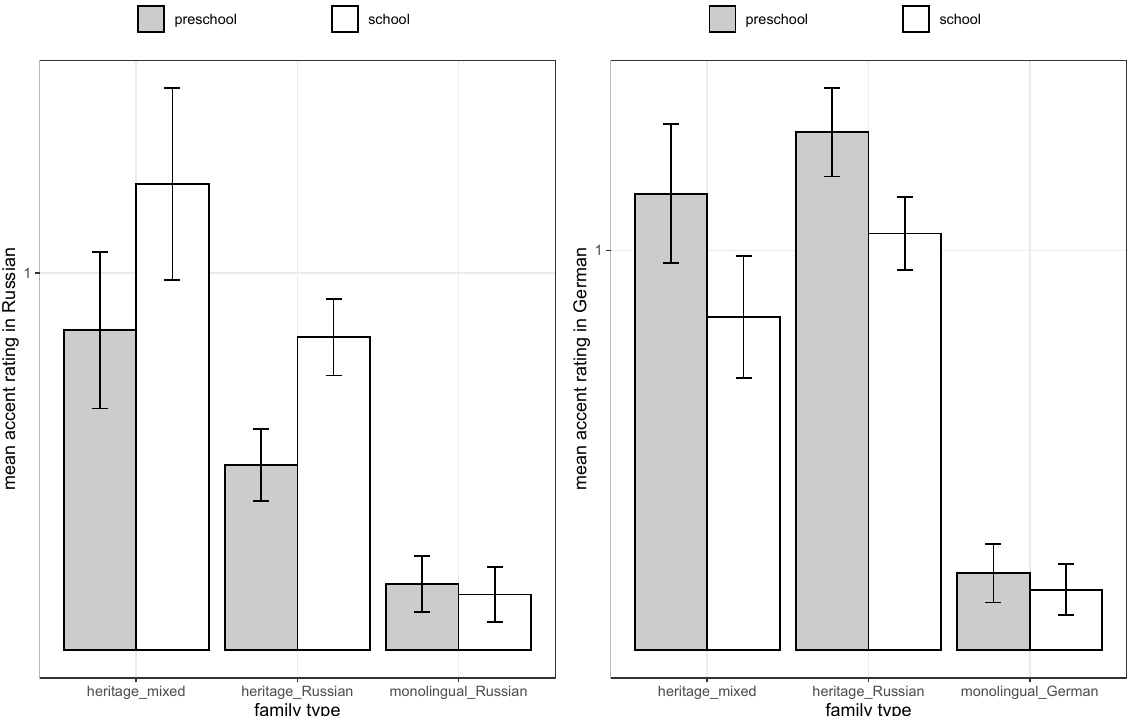
Figure 2. Mean accent ratings in Russian ( left ) and German ( right ) by age group and family type (error bars indicate a 95% confidence interval).